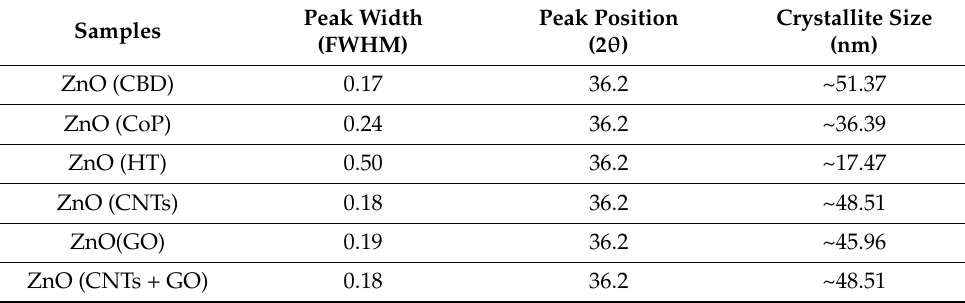
Table 1. Crystallite size of nanostructures and nanocomposites.